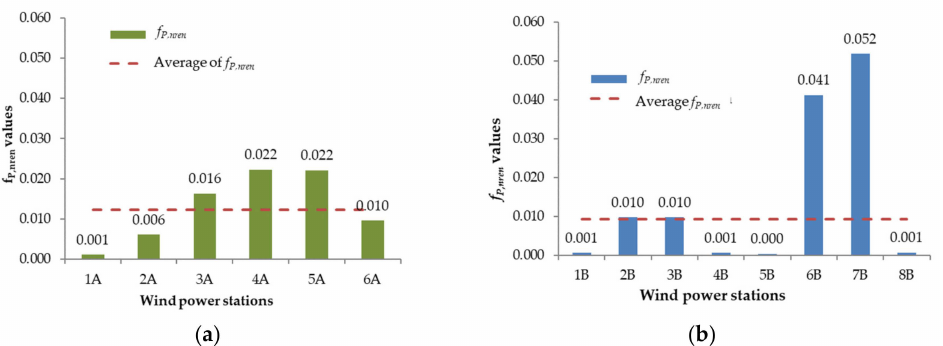
Figure 4. Relationship between f P,nren and wind power in wind turbines / farms: ( a ) in > 10 MW capacity of the wind turbines; ( b ) in < 10 MW capacity of the wind